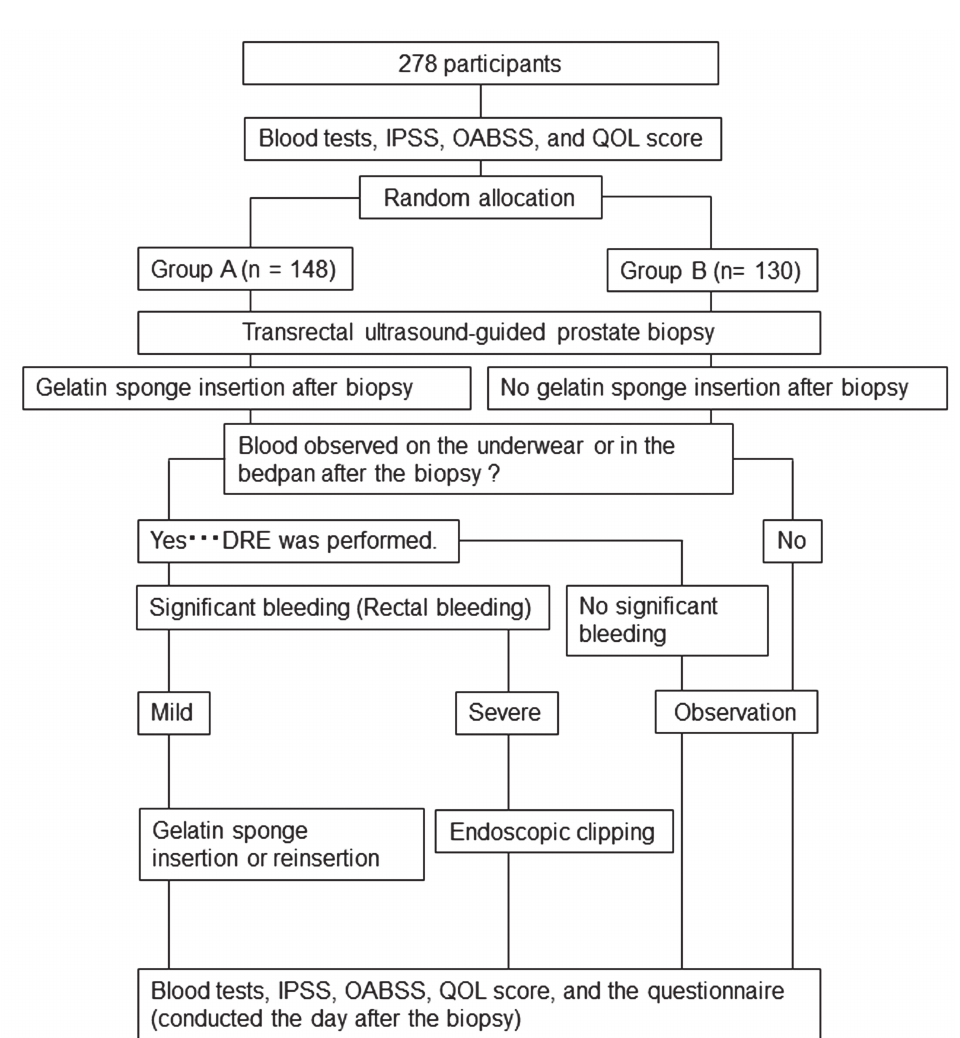
Figure 2 - Flowchart of this